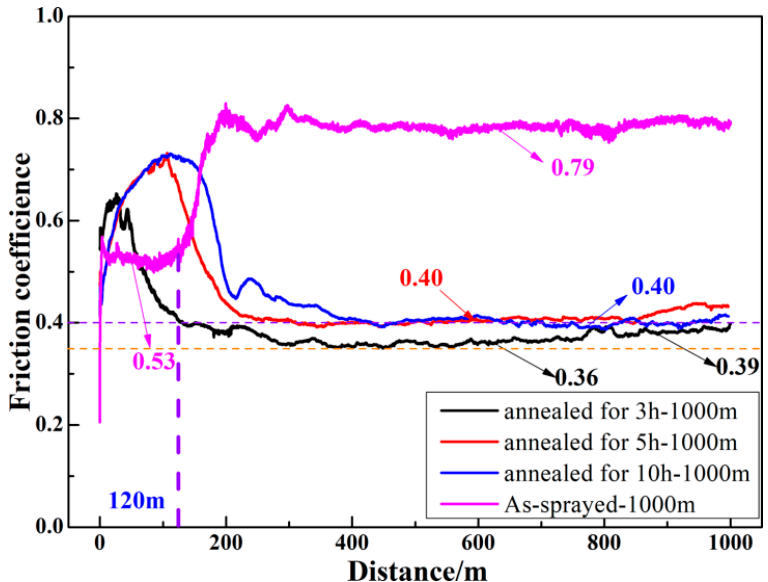
Figure 8. Friction coefficient–distance curves of as-sprayed and annealed CoMoCrSi coatings.